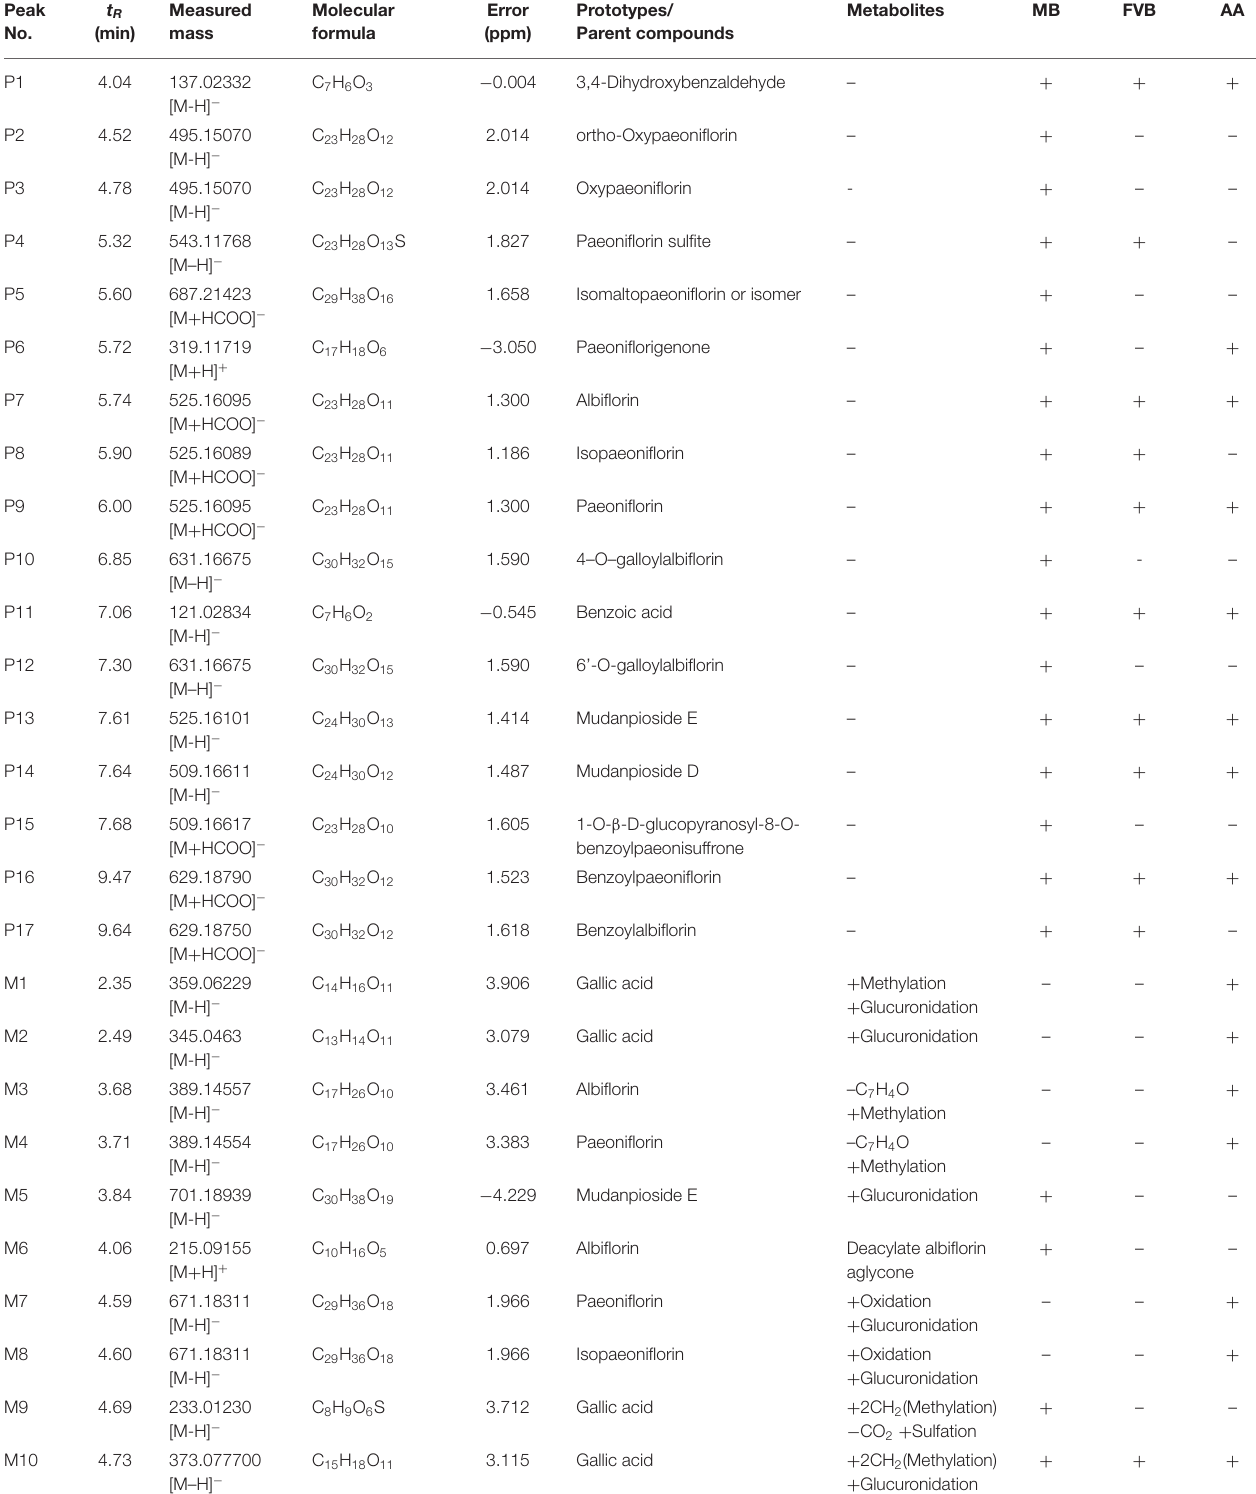
TABLE 2 | Identification of prototypes and metabolites of PRA in different plasma samples by UPLC-Q Exactive Orbitrap HRMS. Peak